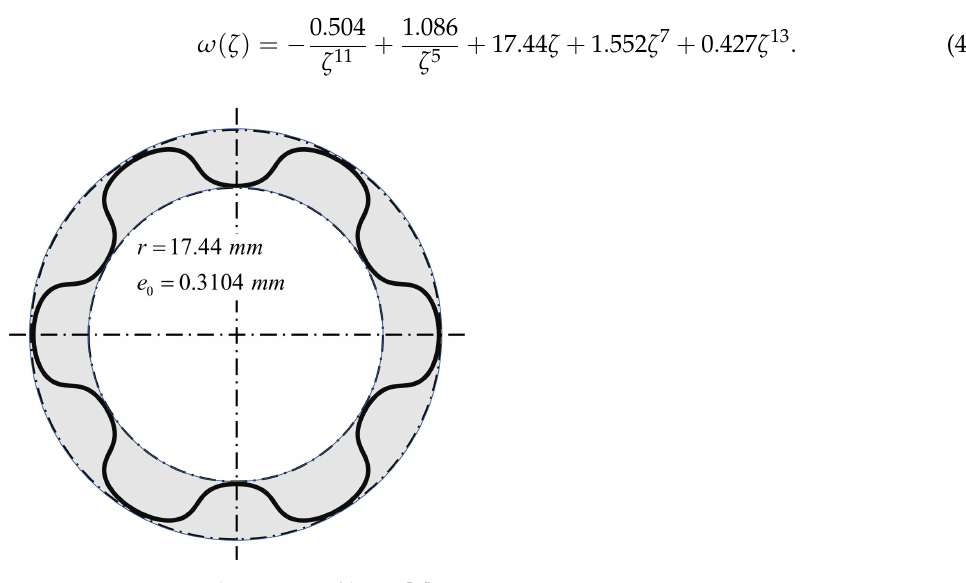
Figure 7. Investigated M-T04 profiles in